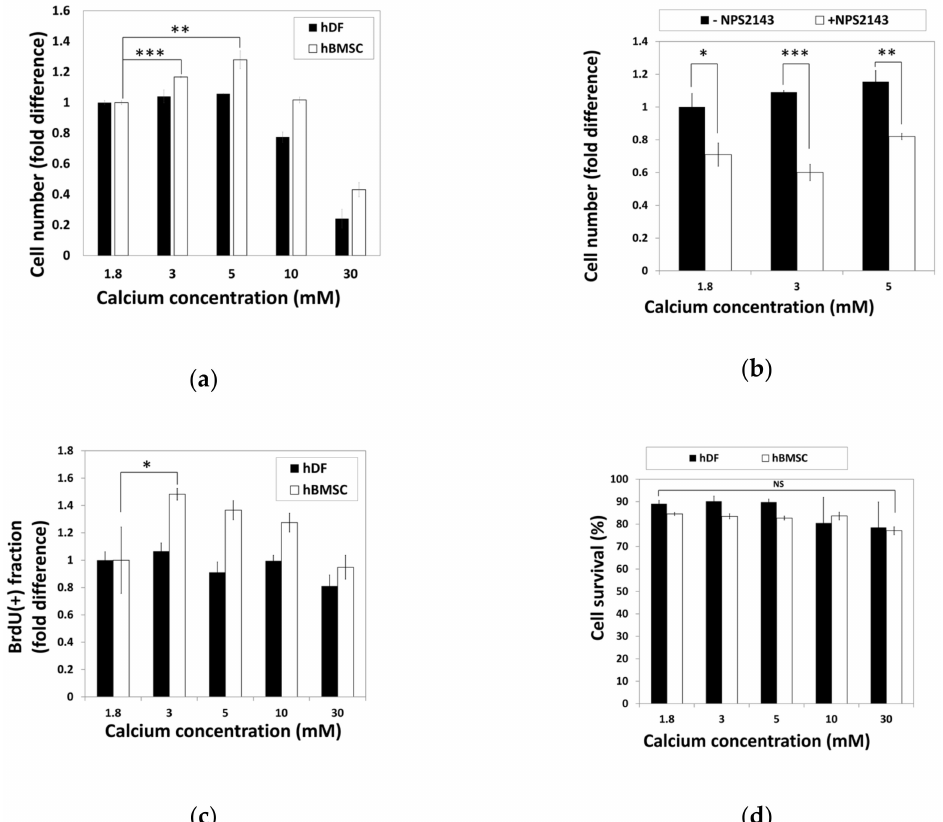
Figure 2. Moderate-high calcium concentration stimulate hBMSC proliferation through CaSR. ( a ) hDFs and hBMSCs were treated with various calcium concentrations for 48 h and relative cell numbers were analyzed by the MTT assay (** p = 0.0038, *** p = 0.0002). ( b ) hBMSCs were treated with NPS2143, a CaSR antagonist. Relative cell density was determined by the MTT assay (* p = 0.0176, ** p = 0.0034, ** p = 0.0004). ( c ) During hBMSC exposure to various calcium concentrations for 48 h, BrdU was treated for the last 24 h. Proportion of BrdU-positive cells was compared as fold difference (* p = 0.0416). ( d ) Comparison of cell survival in response to various calcium concentrations based on the propidium iodide-incorporated apoptotic assay. hDFs and hBMSCs were exposed to various calcium concentrations for 48 h and subjected to propidium iodide (PI) staining. The ratio of PI-negative survival fractions in each group of cells was analyzed by fluorescence-activated cell sorting (FACS) and